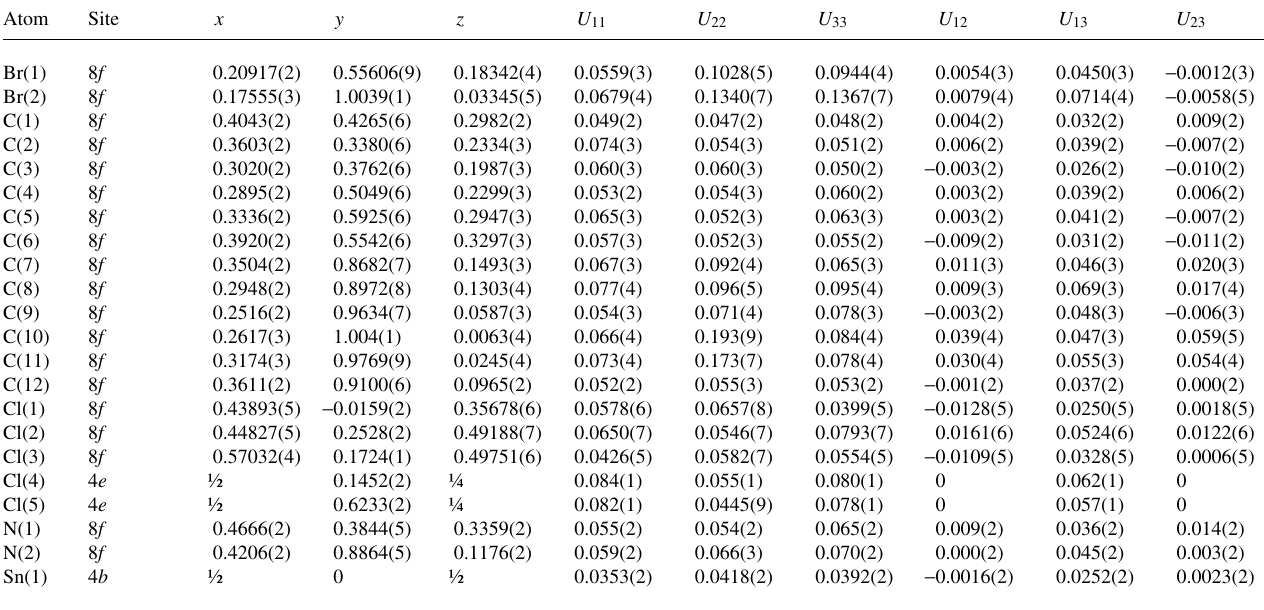
Table 3. Atomic coordinates and displacement parameters (in Å 2 )